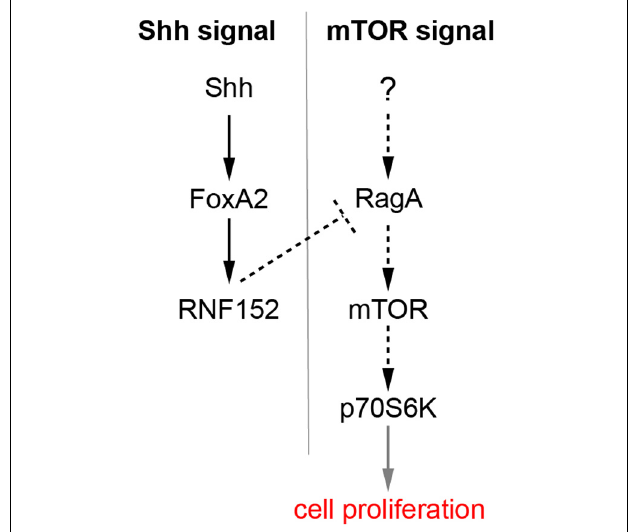
FIGURE 7 | A regulatory loop composed of Shh, FoxA2, and RNF152 modulates FP cell proliferation. FoxA2 expression is induced by Shh, whereas RNF152 is a target gene of FoxA2. RNF152 blocks the cell proliferation through by negatively regulating mTOR signaling. Transcriptional regulation is indicated by solid arrows; activation, and inactivation with protein interactions or modifications are indicated by dotted arrows; the regulation of cell proliferation by the activation of p70S6K is apparently indirect, which is indicated by the gray